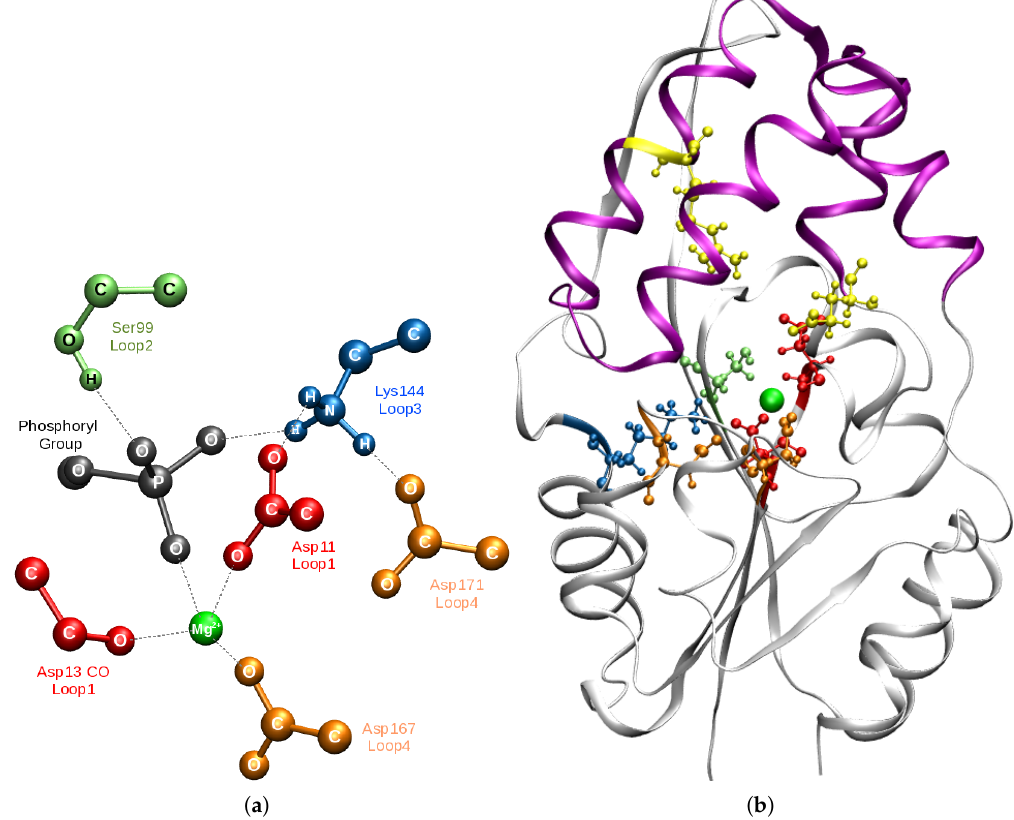
Figure 1. Schematic structural overview of PSP and HAD I superfamily members: ( a ) Catalytic scaffold of PSP comprised of four loops. The backbone carbonyl oxygen of Loop 1 (red) and the carboxyl groups of Loop 4 (orange) bind the Mg 2+ cofactor. The carboxyl group of Asp11 of Loop 1 acts as nucleophile. Loop 2 (lime) and Loop 3 (blue) position the nucleophile and substrate phosphoryl group (black). ( b ) Ribbon diagram of PSP. α / β core domain (white); inserted between Loops 1 and 2 of the core domain is the α -helical-bundle cap domain (violet) that completes the catalytic scaffold by supporting residues Glu20 and Arg56 (Loop 5, yellow). Substrate phospho- L -serine omitted. Phosphoserine phosphatase (PSP) is an important enzyme in the (de-)phosphorylation